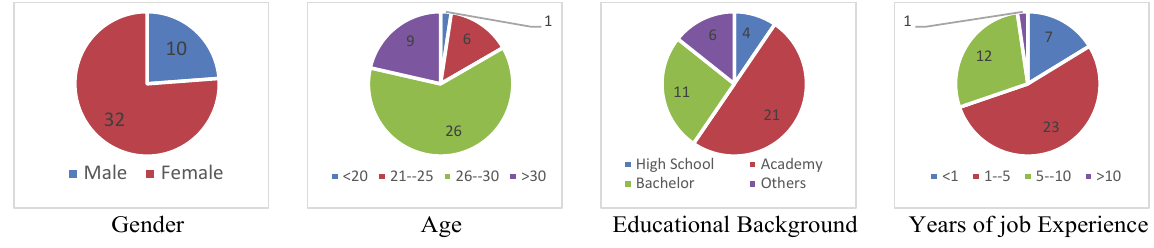
Fig. 3. Personal characteristics of the participants in percentage (Source: From data processing,